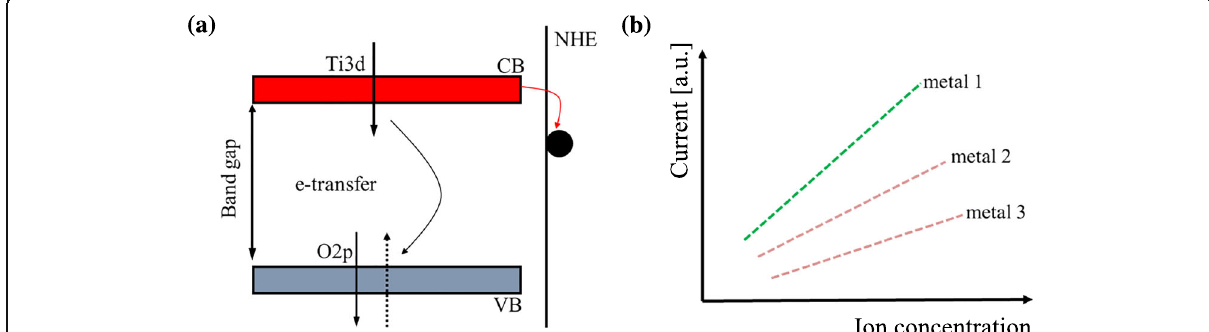
Fig.1 a The schematic diagram of the surface charge transfer between metal and TiO 2 . b Determination of concentration and species of metal ions based on the magnitude of the current induced by the charge